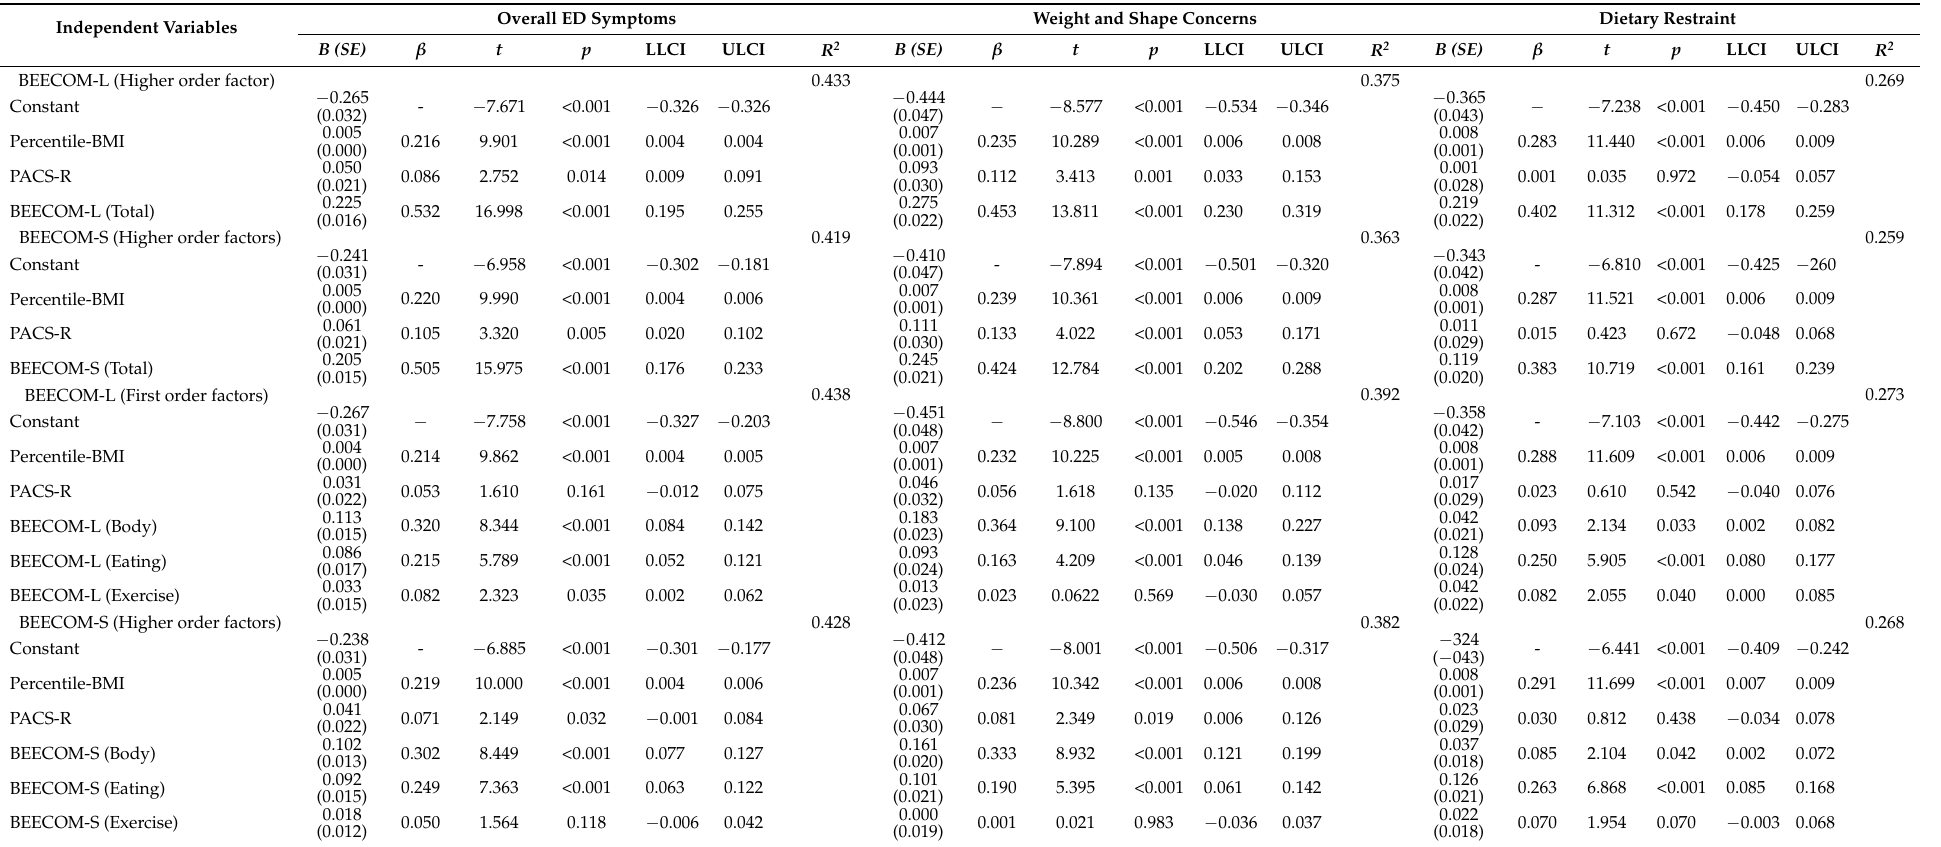
Table 5. Results of regression analyses predicting eating disorder